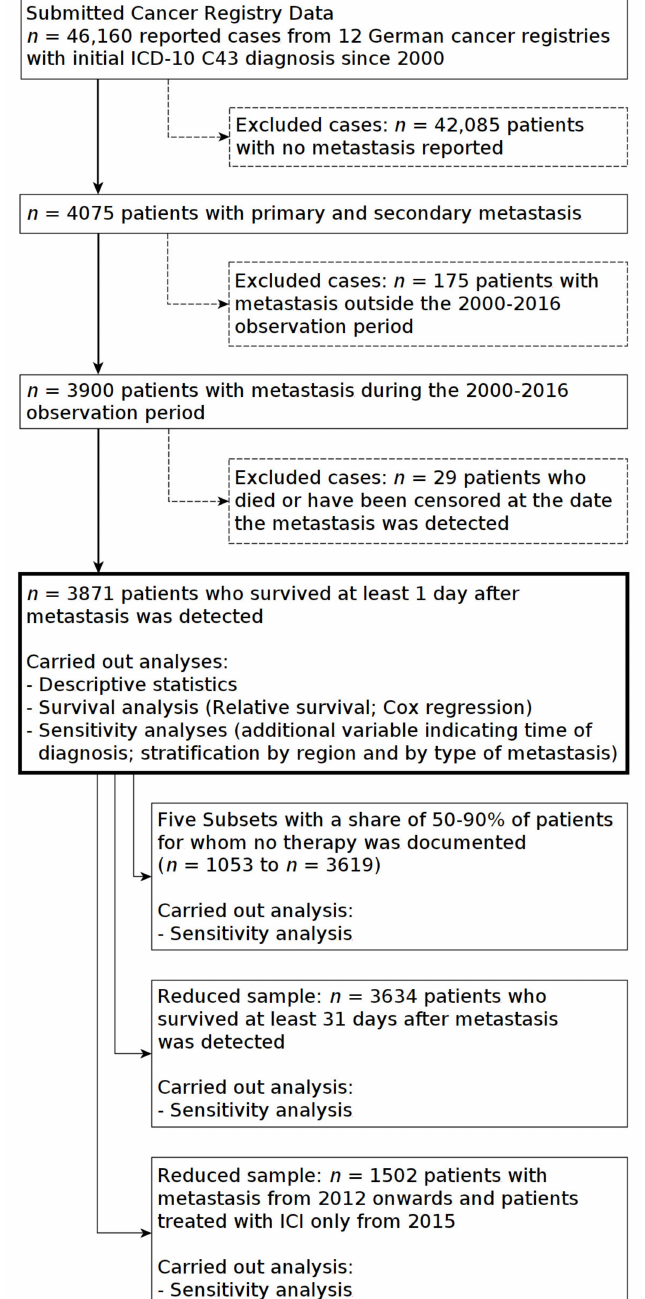
Figure 4. Selection of study populations from cancer registry